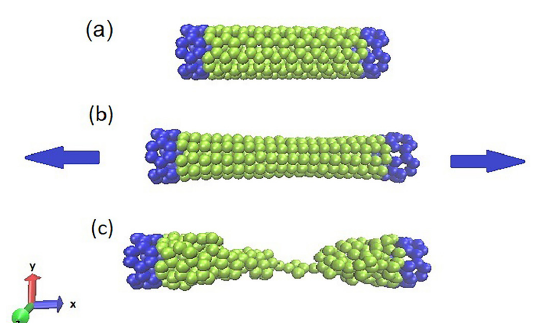
Figure 1. Configuration for tensile process of SiNT. (a) Unstrained, (b) Strained and (c) Fractured conditions.